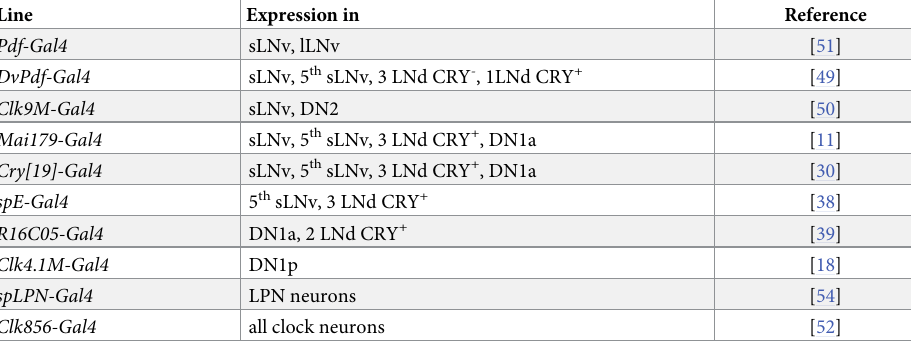
Table 1. List of Gal4 drivers and their expression pattern used in this study.